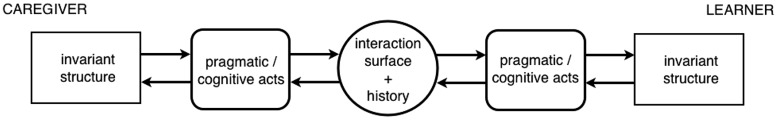
Pragmatic frames involve operations on the cognitive level as well as on the pragmatic or communicative level (together, they constitute the “meaning”). On the cognitive level, we distinguish between (1) perceptual functions and (2) functions pertaining to the representational organization of knowledge. Perceptual functions include low-level processing such as segmentation and classification whereas functions pertaining to the representational organization of knowledge include instantiating a new knowledge item, retrieving or correcting an existing knowledge item. The pragmatic level includes knowledge about the interactional requirement and the pragmatic role of the participants, e.g., that a question is followed by an answer. Interactional experience (history of interaction) is the driving force for deep meaning and deep syntax as constituents of an invariant structure.